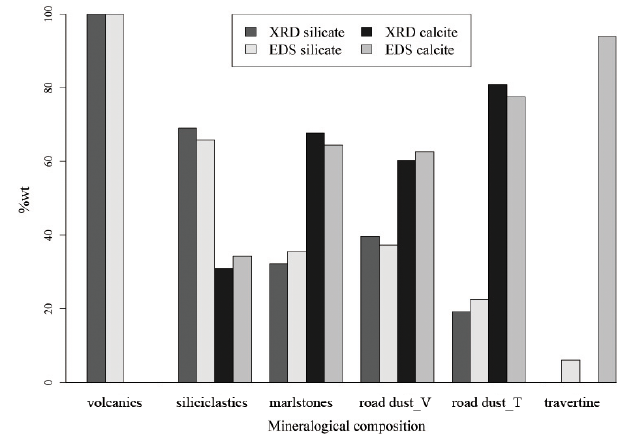
Figure 3. Total silicate (including quartz) and calcite amounts (wt%) of dust samples, obtained by X-ray diffraction bulk analy- sis and SEM XEDS particle